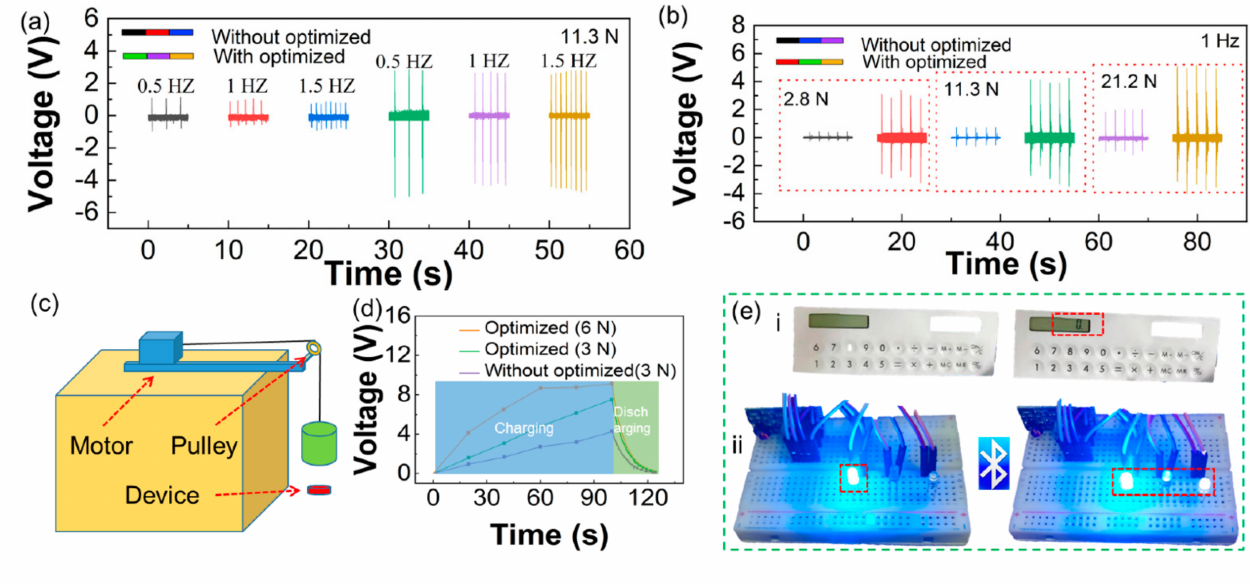
Figure 1. The structure, working mechanism, and application in the sport scene of the portable mobile gait monitor system. ( a ) The practical application of TENG in the sport scene. ( b ) The optical picture and installation position of TENG. ( c ) The structure of TENG. ( d ) The working mechanism of TENG. ( e ) Portable mobile gait monitor system.